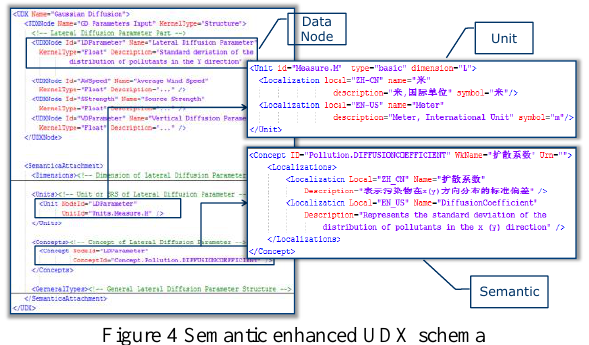
Figure 4 Semantic enhanced UDX schema